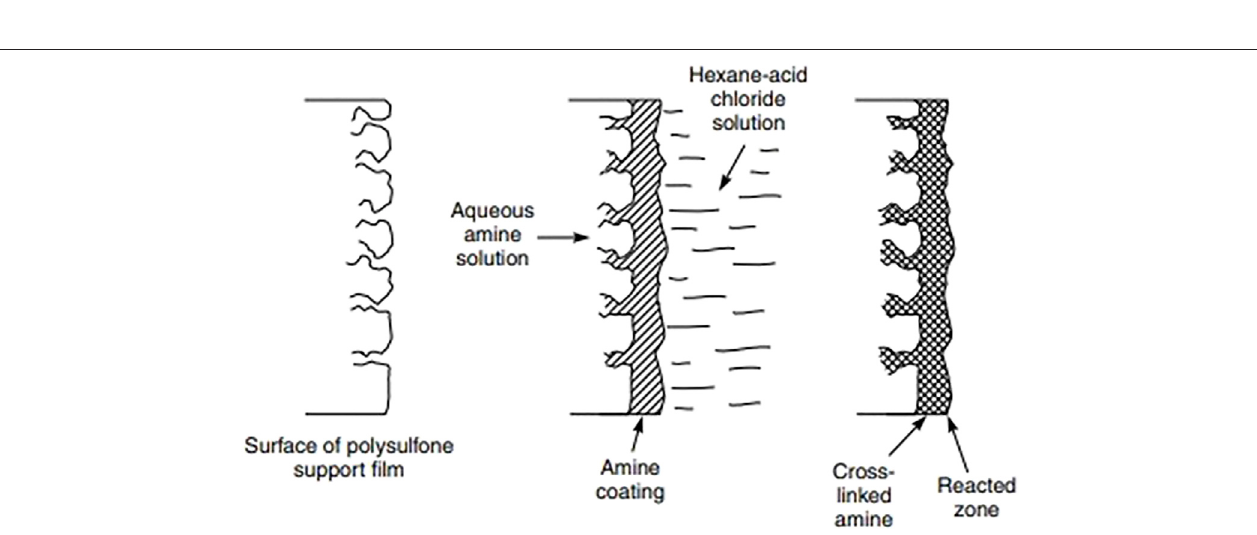
FIGURE 4 | Schematic of the interfacial polymerization process (Kim and Deng, 2011).